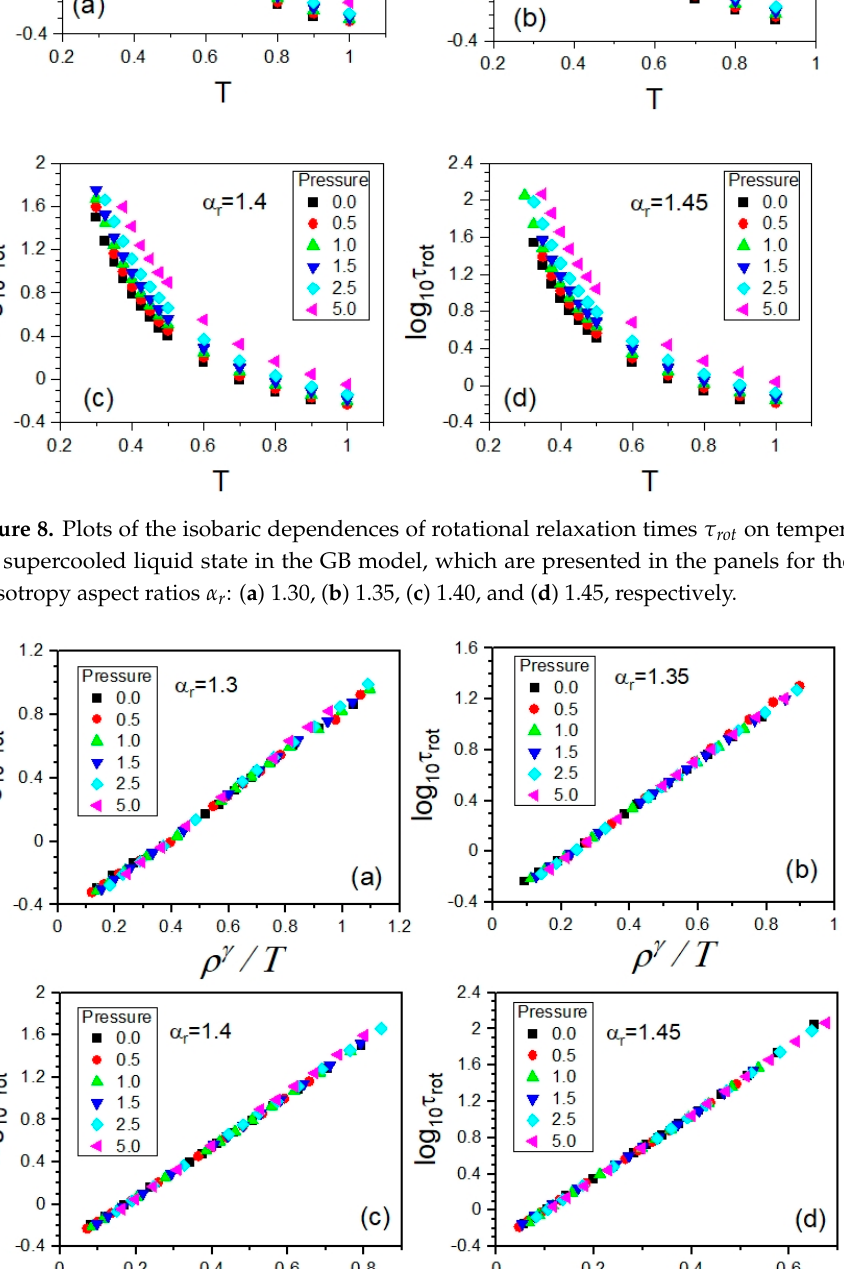
for different rot